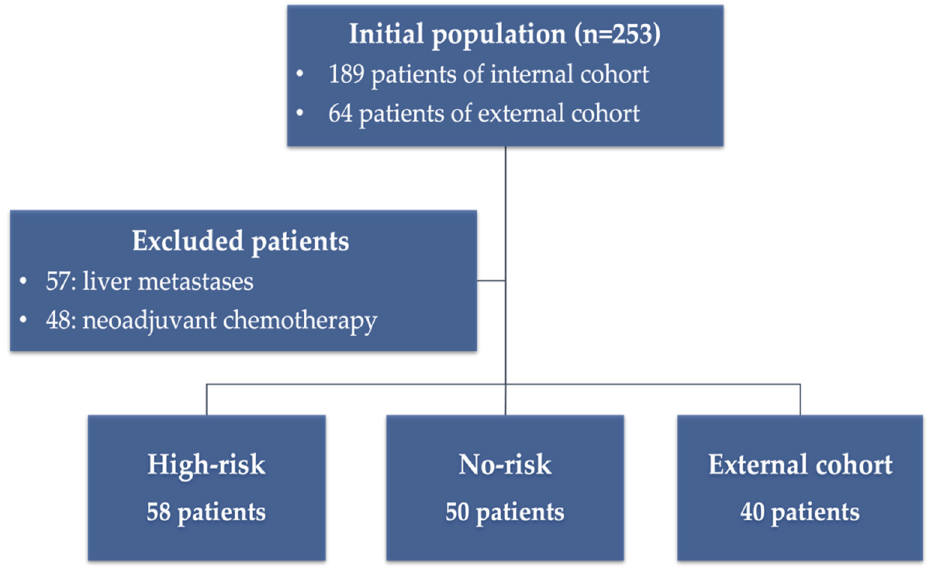
Figure 1. Patient recruitment flow-chart.